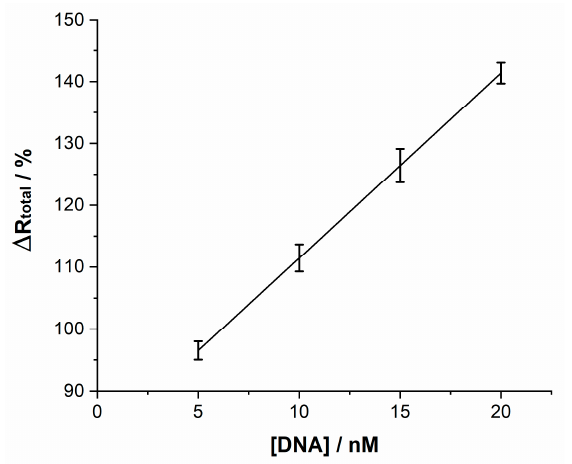
Figure 8. Sensitivity of the DNA biosensor at different concentrations of DNA.